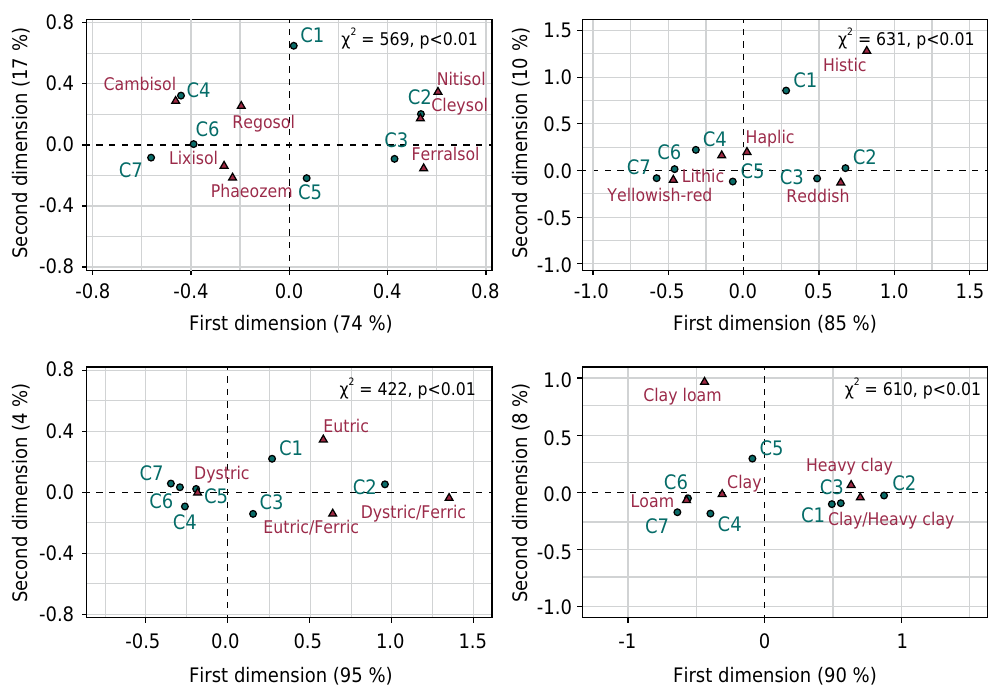
Figure 5. Correspondence analysis of landscape clusters with information derived from the dominant class from the semi-detailed soil map: first categorical level (a), second categorical level (b), third categorical level, and subsurface soil texture